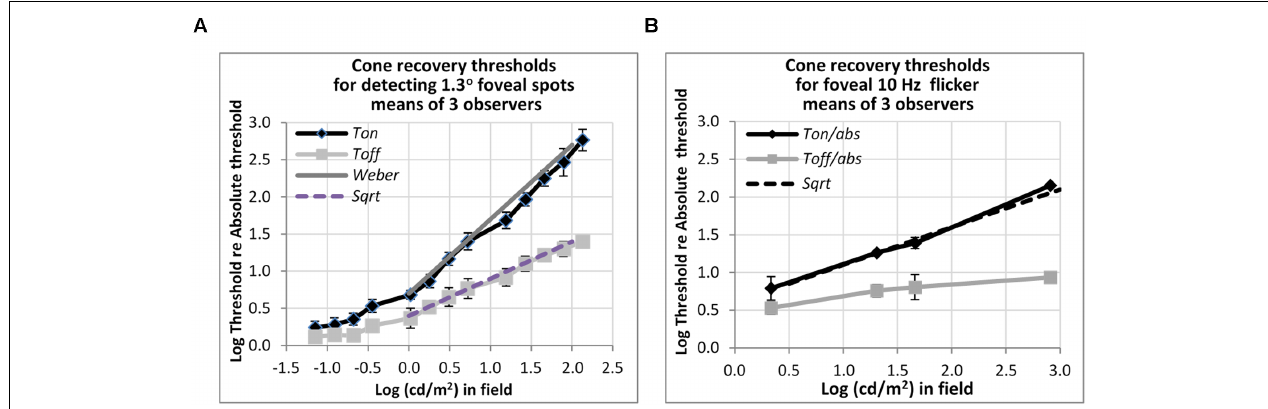
previous study and one new) and are plotted as a function of background